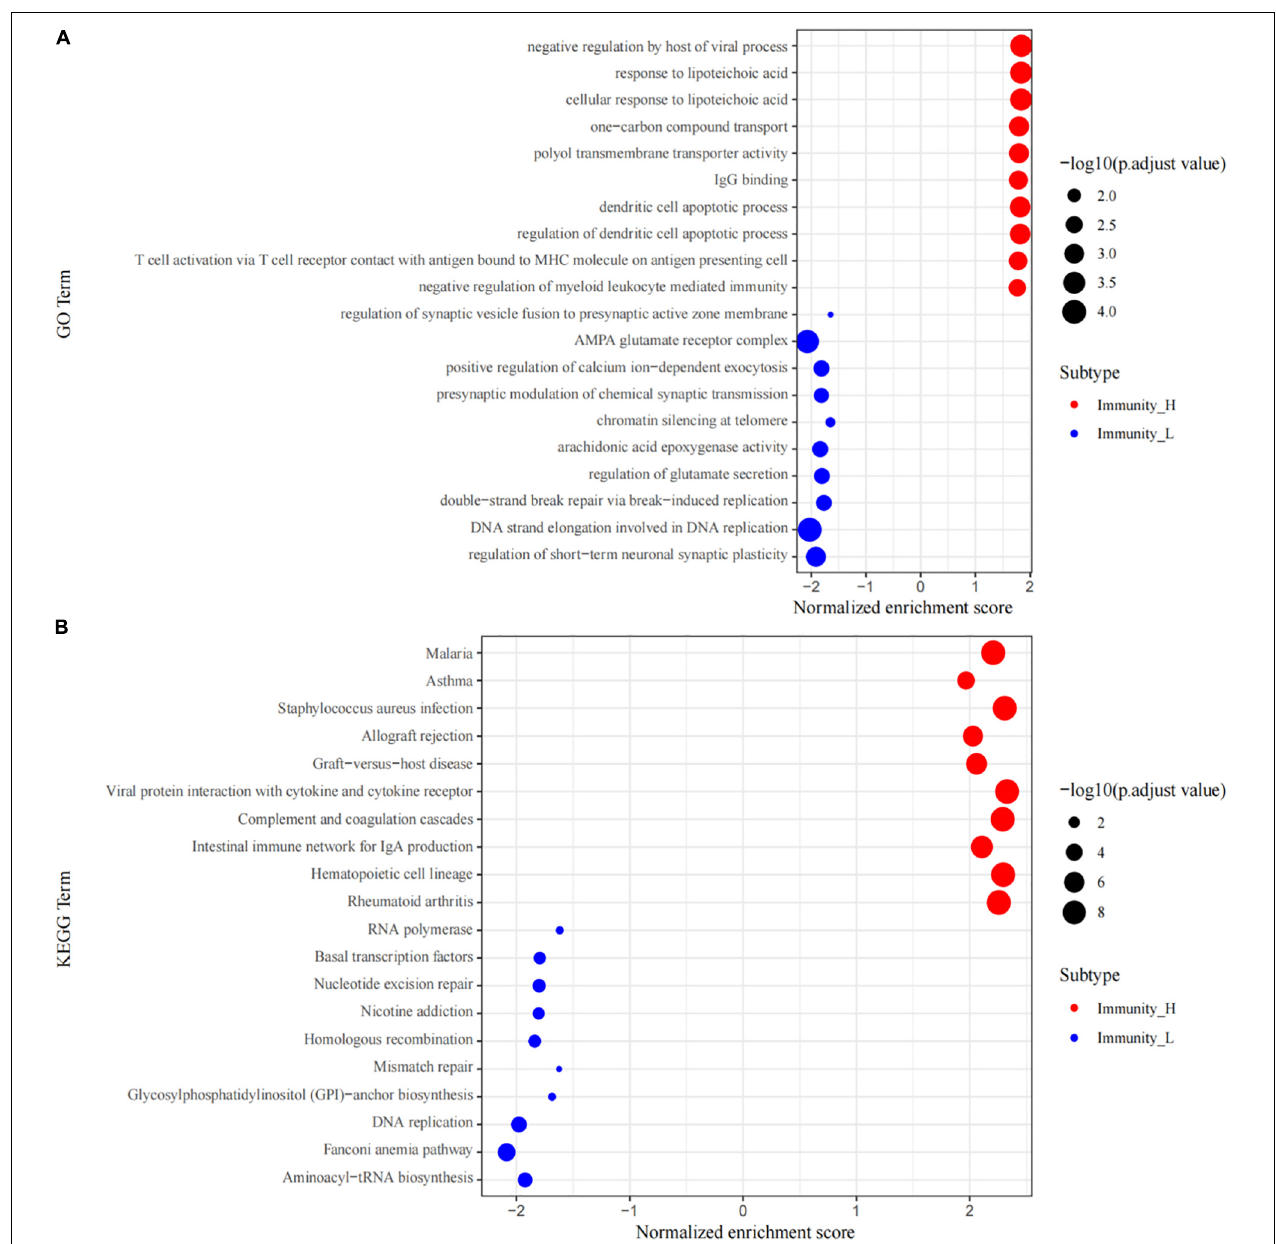
FIGURE 3 | GSEA enrichment analysis. (A) The top 10 results of GO analysis in Immunity_H (red) and Immunity_L (green). (B) The results of KEGG analysis in Immunity_H (red) and Immunity_L (green).